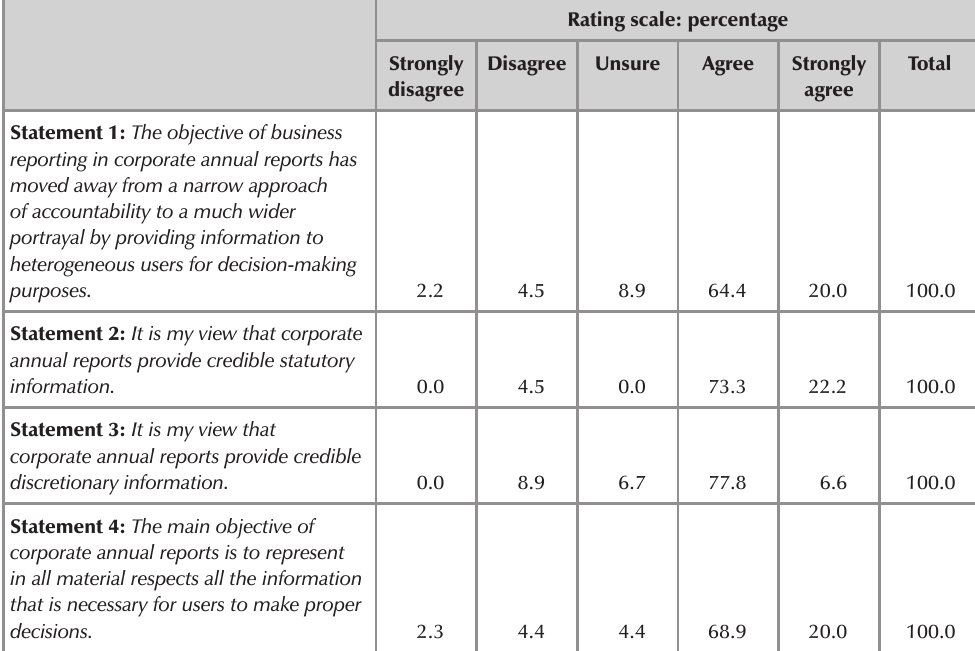
Responses of preparers of corporate annual reports (n=45) Rating scale: